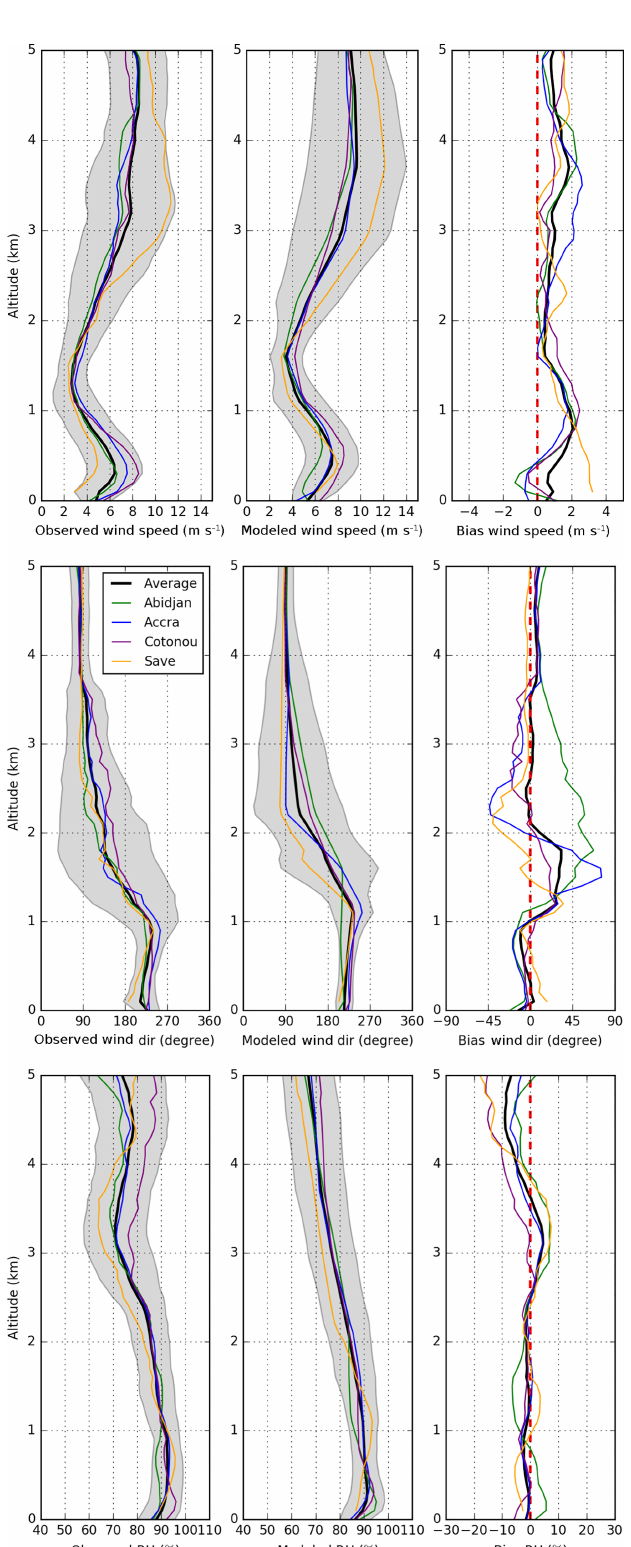
Figure 3. Observed and modeled mean vertical profiles of wind speed (ms − 1 ) and direction (360 ◦ circle with 0 and 360 ◦ is the north and 90 ◦ is the east) and relative humidity (RH in %) averaged for all profiles over the period of 1–7 July 2016 at Abidjan in Côte d’Ivoire (green line), Accra in Ghana (blue line), Cotonou in Benin (purple line), and Savè in Benin (orange line). The mean and standard deviation at the four locations are represented by the black line and the gray shading. WRF-derived variables are interpolated to the radiosonde positions. The right panel presents the (mod–obs) mean vertical bias of each location and of the average of the four